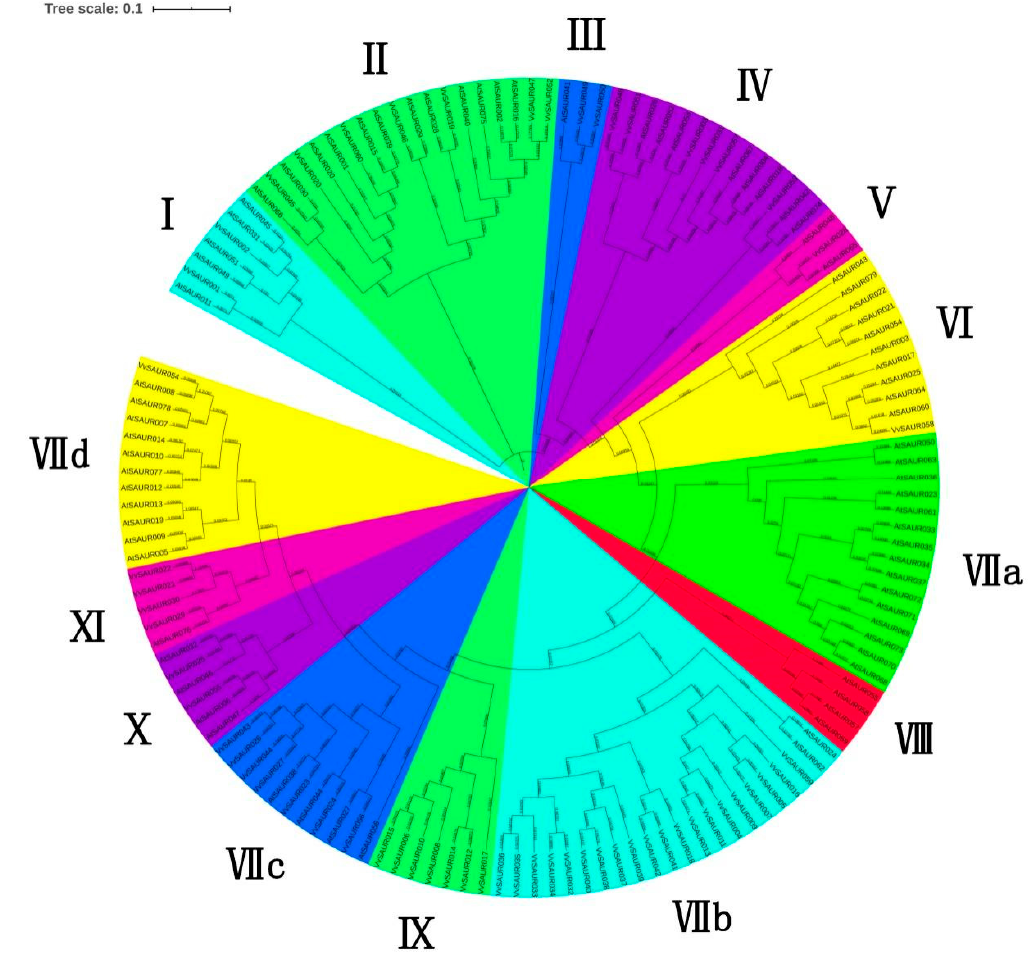
Figure 2. An unrooted phylogenetic tree of the VvSAUR family. Phylogenetic tree was constructed online with Interactive Tree of Life (iTOL). Numbers are bootstrap values based on 1000 iterations. Only bootstrap values larger than 50% support are displayed.